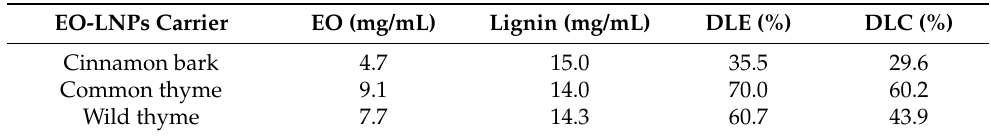
Table 2. Essential-oil loading, drug-loading efficiency (DLE) and drug-loading capacity (DLC) of